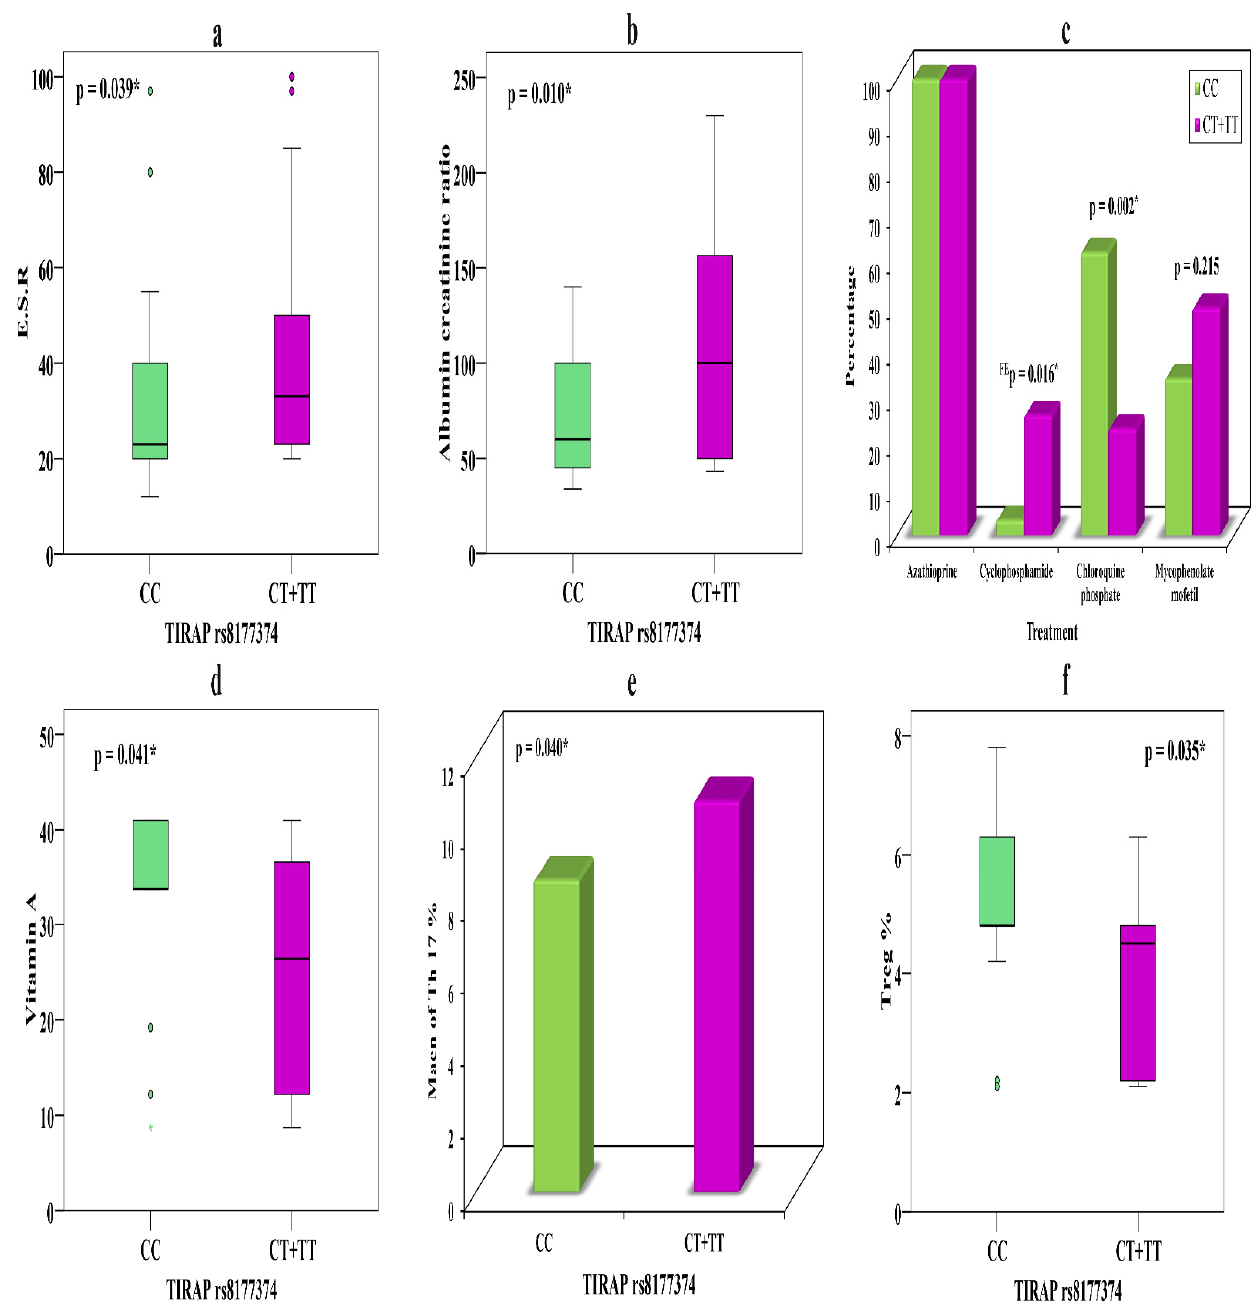
Figure 2. ( a ) Relationship between TIRAP rs8177374 and ESR in LN. ( b ) Relationship between TIRAP rs8177374 and ACR in LN. ( c ) Relationship between TIRAP rs8177374 and treatment in LN. ( d ) Relationship between TIRAP rs8177374 and vitamin A in patients without nephritis. ( e ) Relationship between TIRAP rs8177374 and Th17 % in patients without nephritis. ( f ) Relationship between TIRAP rs8177374 and Treg % in patients without nephritis. *—significant.